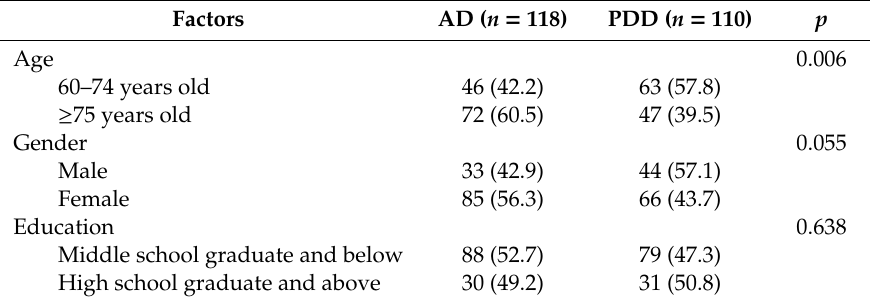
Table 1. Characteristics of the participants based on type of dementia, chi-square test, n